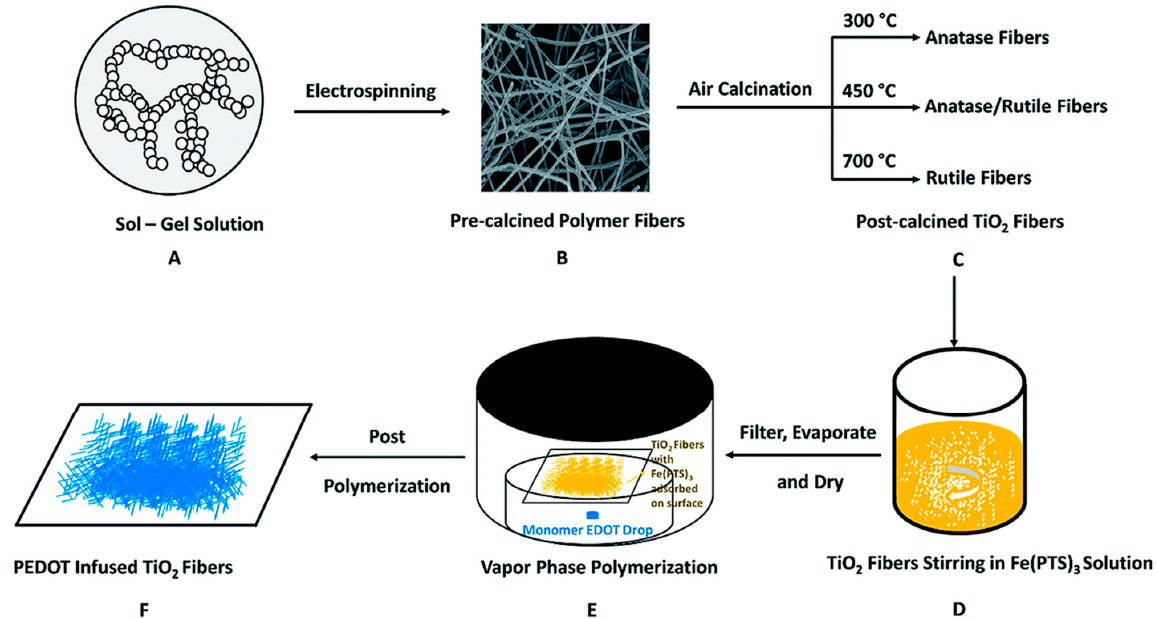
Figure 2. The preparation process of PEDOT infused TiO 2 nanofibers via electrospinning and calcination [67]: ( A ) Sol– gel solution containing PMMA, precursor TTIP and the solvents; ( B ) post-electrospinned polymer fibers containing PMMA, amorphous TiO 2 and solvent without evaporating; ( C ) post-calcined TiO 2 nanofibers under different calcination temperatures with different phase compositions; ( D ) stirring of post-calcined TiO 2 nanofibers with yellow oxidant Fe(PTS)3 solution; ( E ) dried TiO 2 nanofibers with adsorbed Fe(PTS)3 on surface were put in a heated chamber for VPP reaction; ( F ) bluish dried PEDOT infused TiO 2 nanofibers on filter